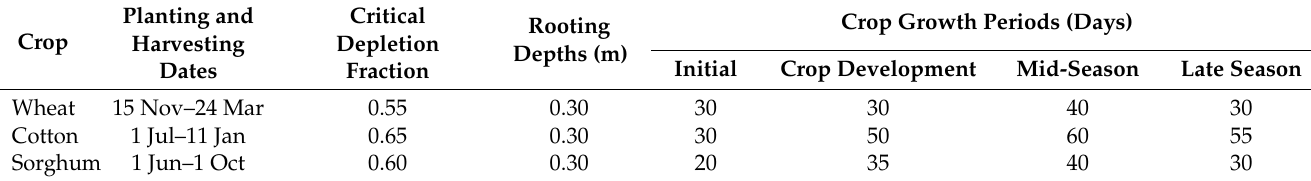
Table 3. Crop data.